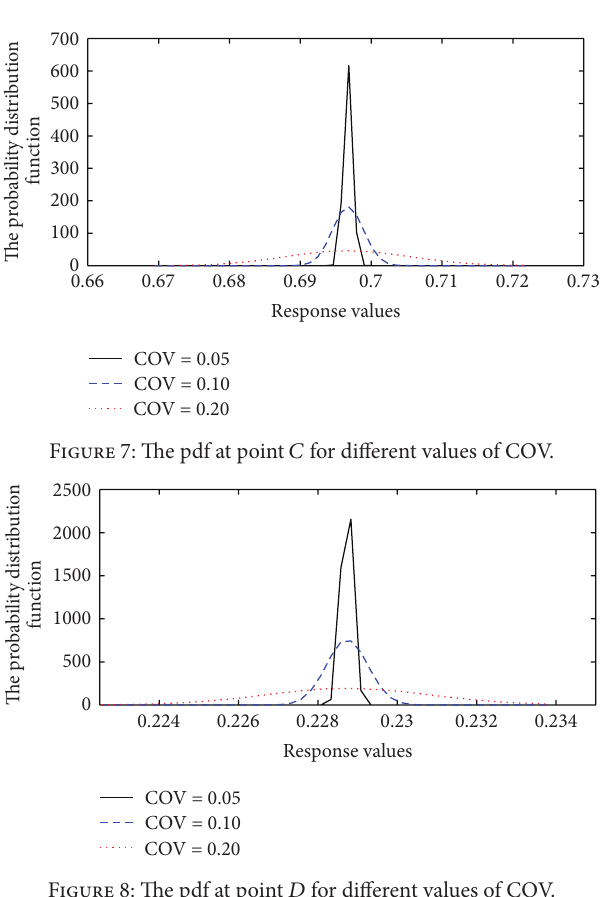
Figure 8: The pdf at point 𝐷 for different values of COV.